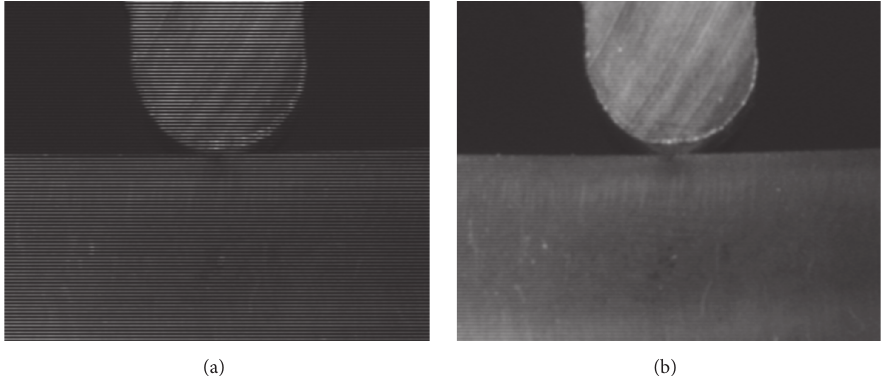
Figure 1: Gray distribution images of the specimen surface. (a) One acquisition; (b) twice light intensity